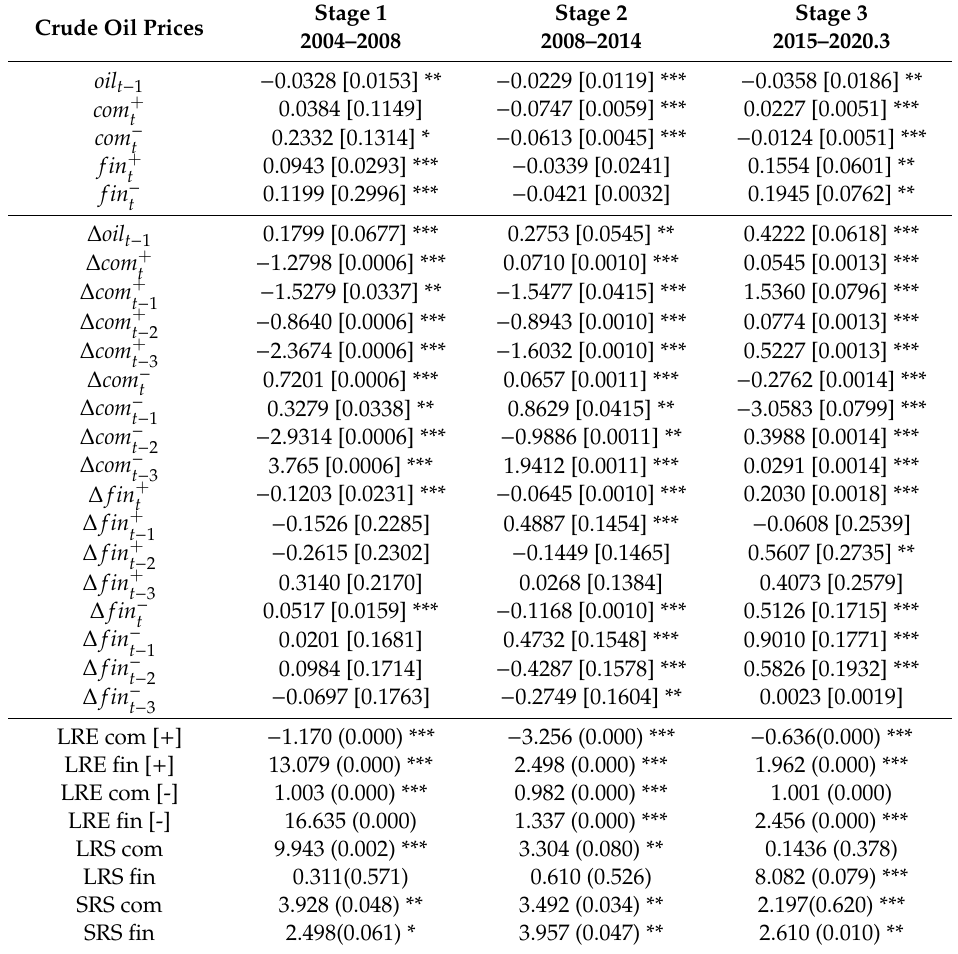
Table 4. The estimation results of the nonlinearity autoregressive distribute lag approach (NARDL) model. Crude Oil